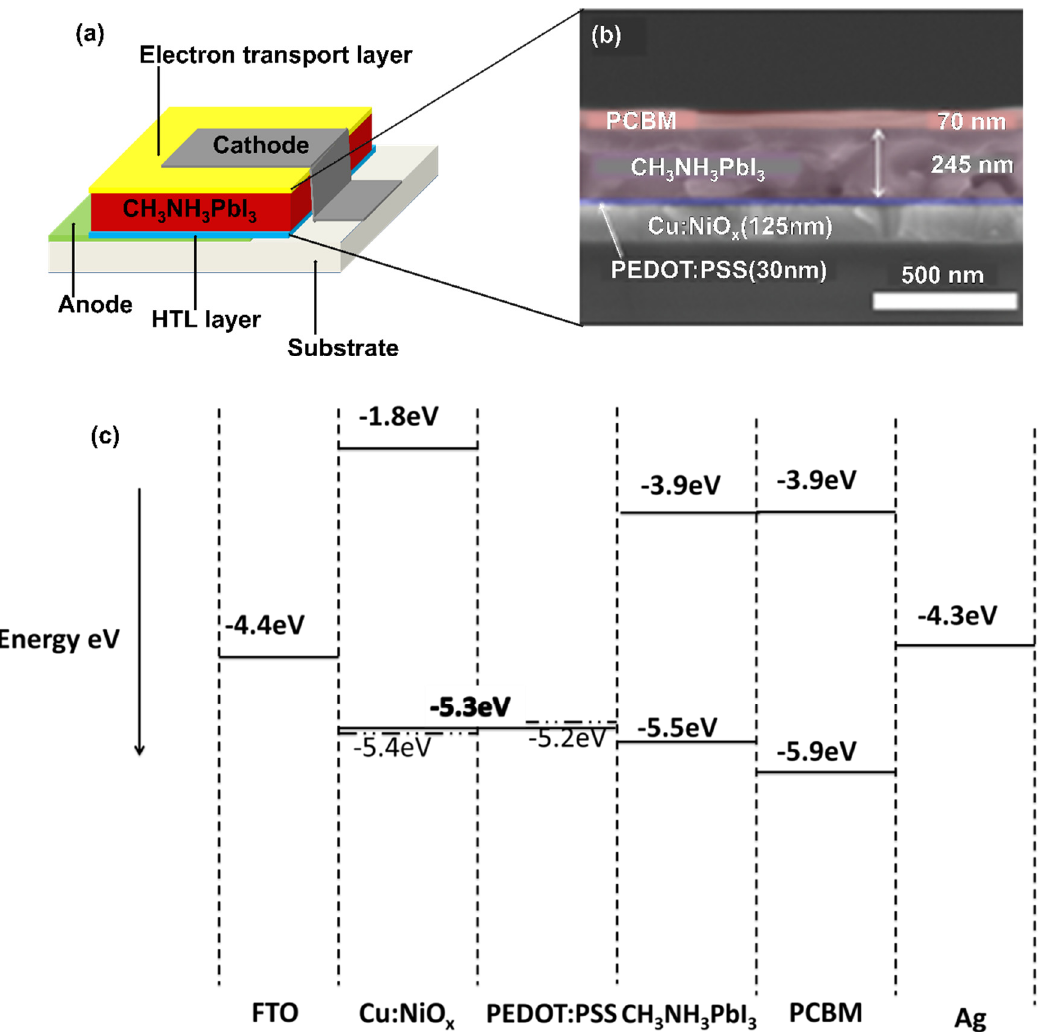
Figure 1. ( a ) The device configuration with a PEDOT:PSS/Cu:NiO x composite hole transportation layer (HTL); ( b ) cross-sectional view of the perovskite-based solar cell with a scanning electron microscope; ( c ) energy-level diagram of the different components of the perovskite solar cell (PSC) device obtained from ultraviolet-visible UV spectroscopy analysis.